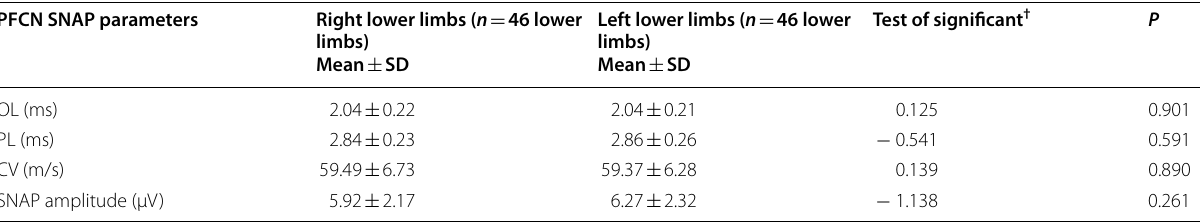
PFCN, posterior femoral cutaneous nerve; SNAP, sensory nerve action potential; OL, onset latency; PL, peak latency; CV, conduction velocity; n , number of lower limbs; SD, standard deviation